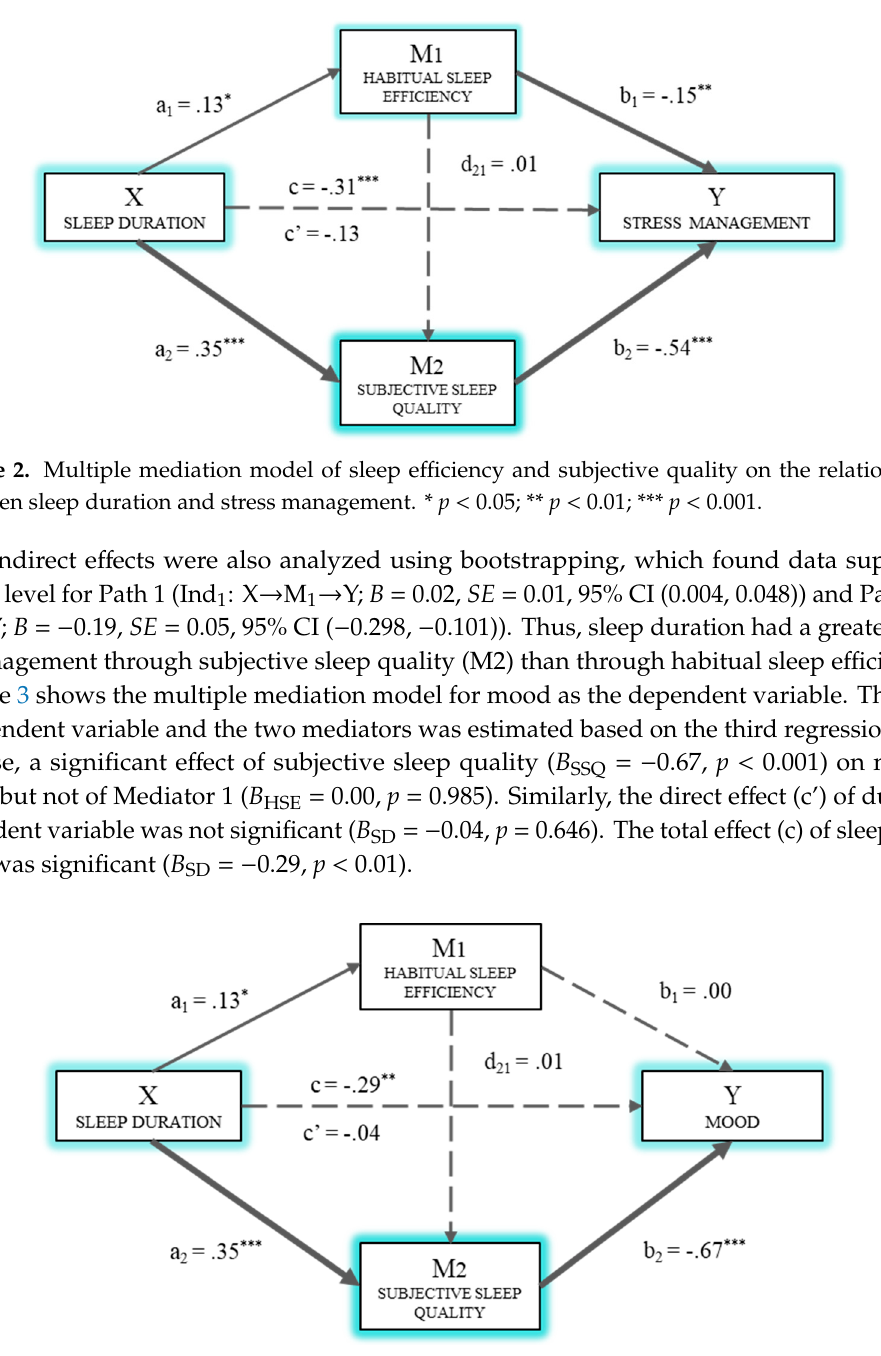
Figure 3. Multiple mediation model of sleep efficiency and subjective sleep quality on the relationship between sleep duration and mood. * p < 0.05; ** p < 0.01; *** p < 0.001.